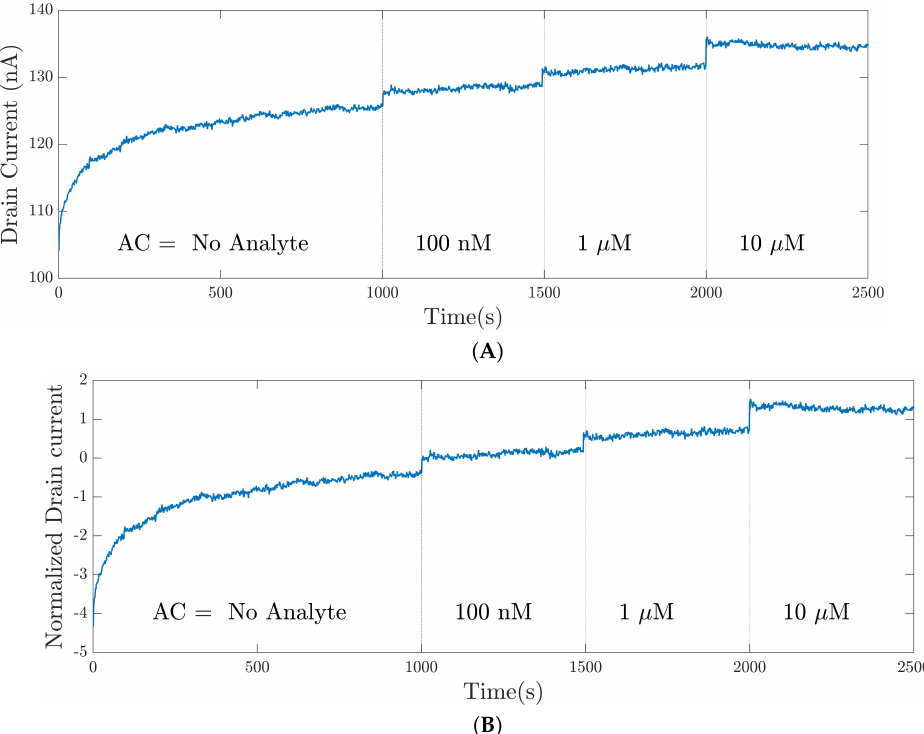
Figure 8. Preprocessed signal for the 35-mer adenosine dataset according to the Z-score scaling: ( A ) the raw signal; ( B ) the preprocessed